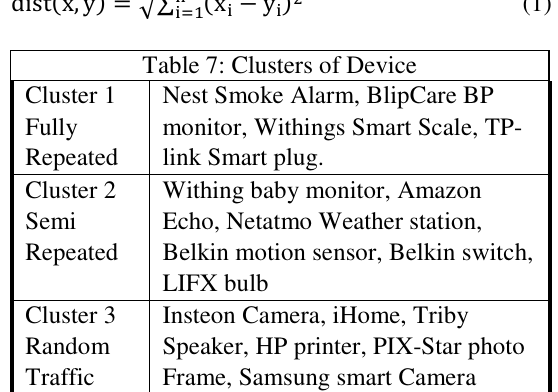
Table 6: Samsung Smart Camera Profile